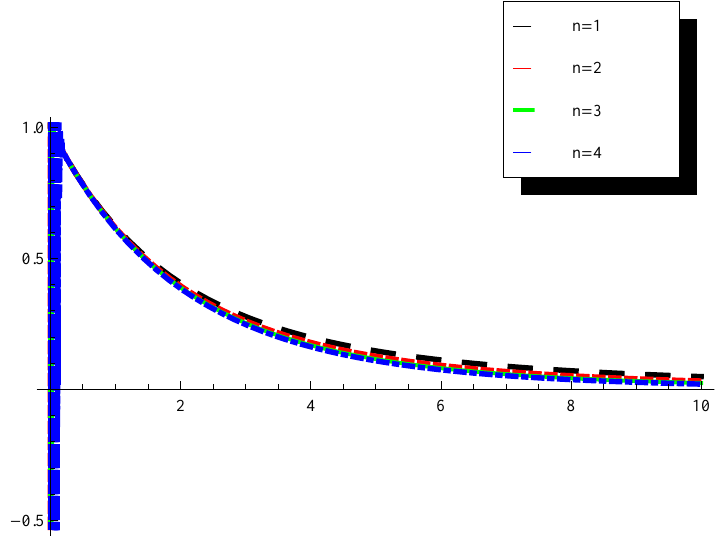
Figure 3. Hypergeometric1F1 [ 1 + n ,2 + n , − t ] .